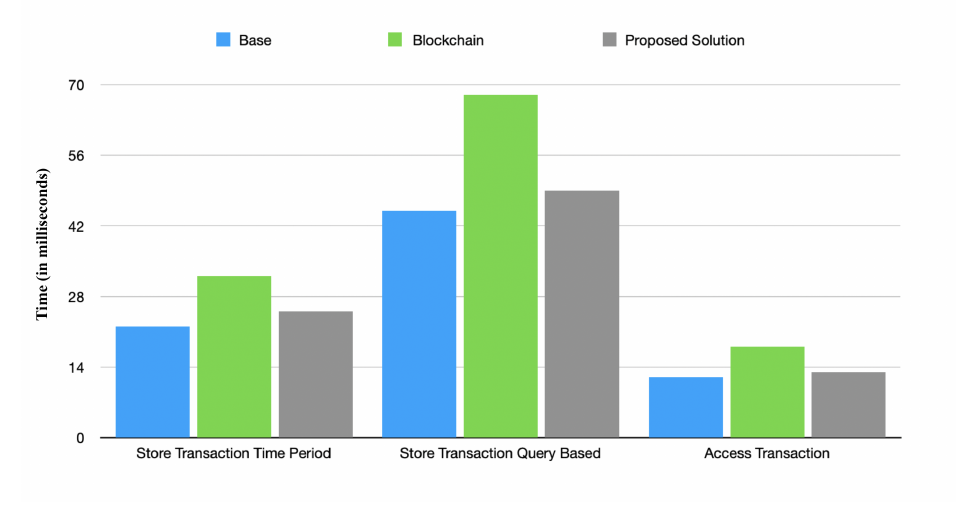
Figure 7. Time Overhead evaluation.